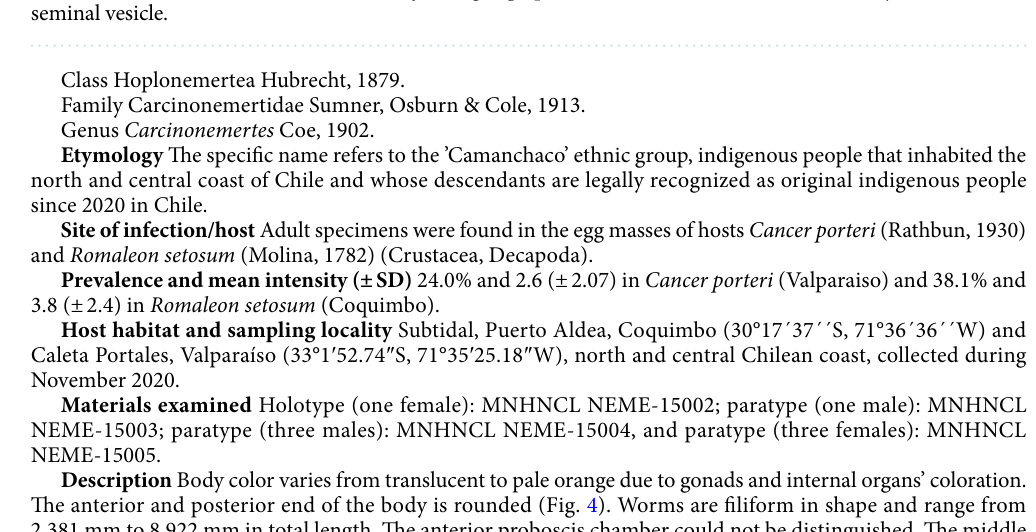
Description Body color varies from translucent to pale orange due to gonads and internal organs’ coloration. The anterior and posterior end of the body is rounded (Fig. 4). Worms are filiform in shape and range from 2.381 mm to 8.922 mm in total length. The anterior proboscis chamber could not be distinguished. The middle chamber contains a single stylet (Figs. 5, 6). The stylet appears like a dagger with a broad- stylet basis (Figs. 4e,